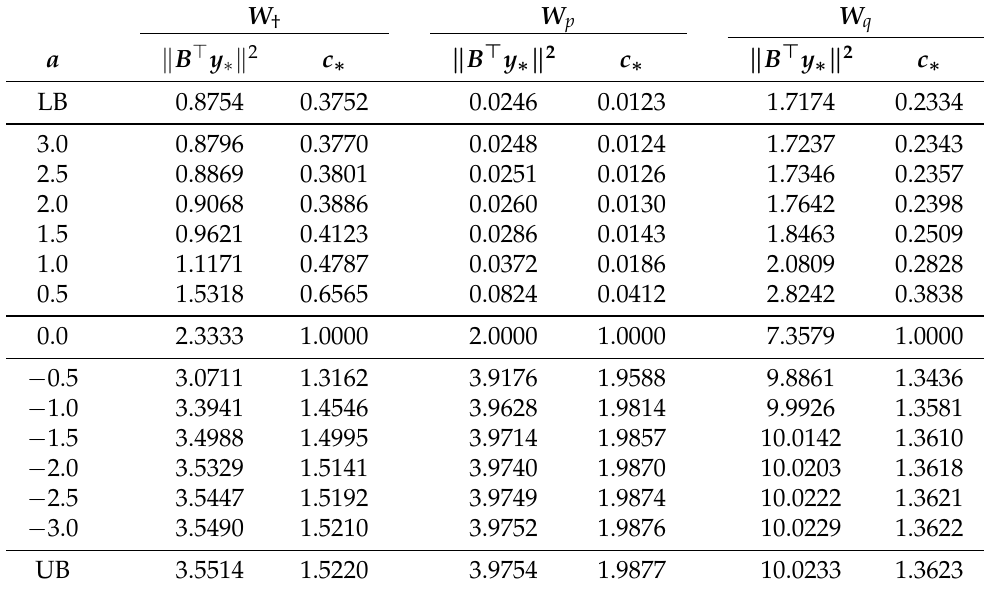
Table 1. Spatial smoothness and Geary’s c